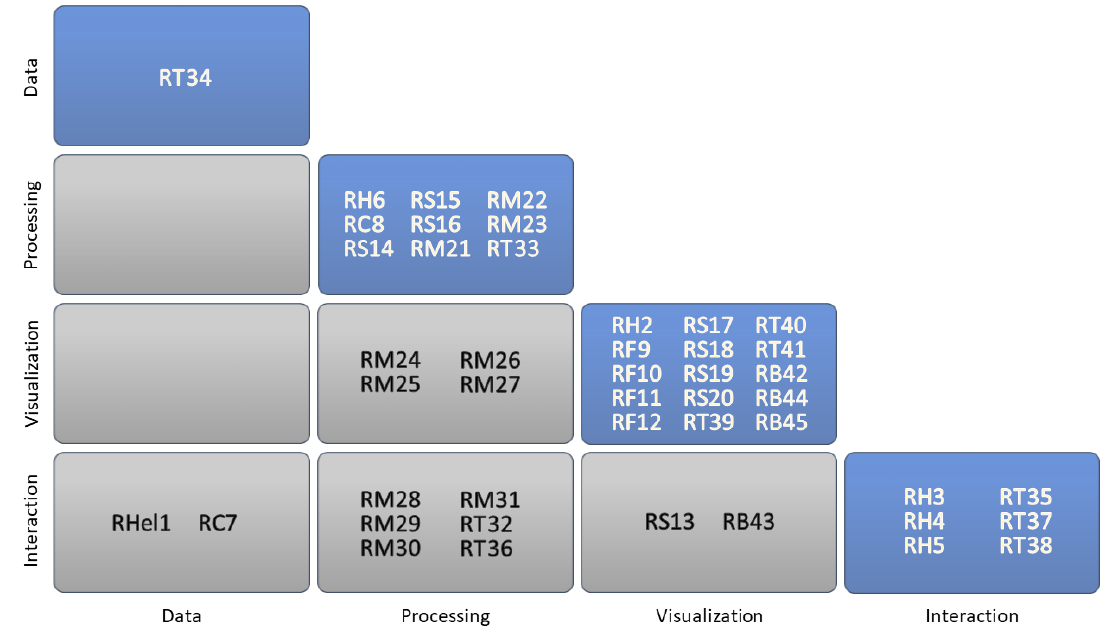
Figure 2. The requirements from Appendix A1 linked to the different aspects of PVA: The main diagonal lists requirements, which relate to a single PVA aspect. Other cells list requirements concerning two PVA aspects. The shorthands relate to the following publications: R Hel [10], R H [28], R C [25], R F